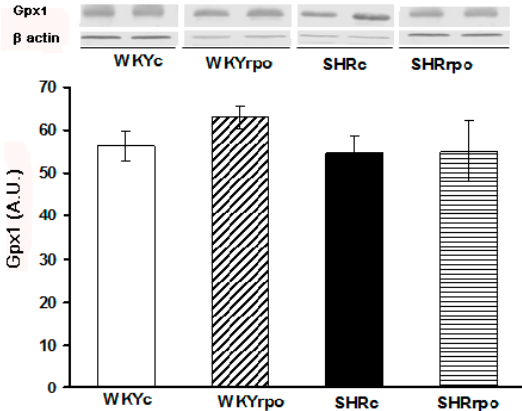
Figure 2. Effect of dietary red palm oil (RPO) supplementation on the protein expression of glutathione peroxidase 1 (Gpx1) in the left ventricle of normotensive and hypertensive rats. WKYc— Wistar Kyoto control rats; WKYrpo—WKY treated with RPO; SHRc—Spontaneously hypertensive rats; SHRrpo—SHR treated with RPO; Results are expressed as mean ± SEM; n = 5 in each group.